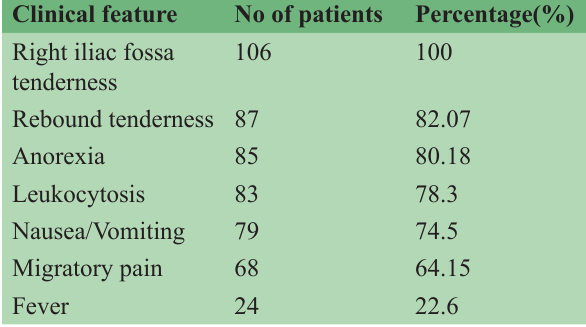
Table 1: The clinical features of the patients